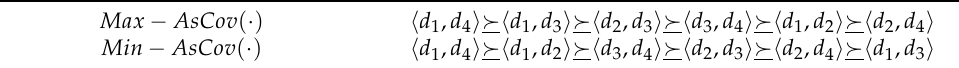
Table 8. Ranking of alternatives pairs by the statistical independency relation (cid:31) AsCov , using the functions F − AsCov ( · ) ( F = Max or F = Min